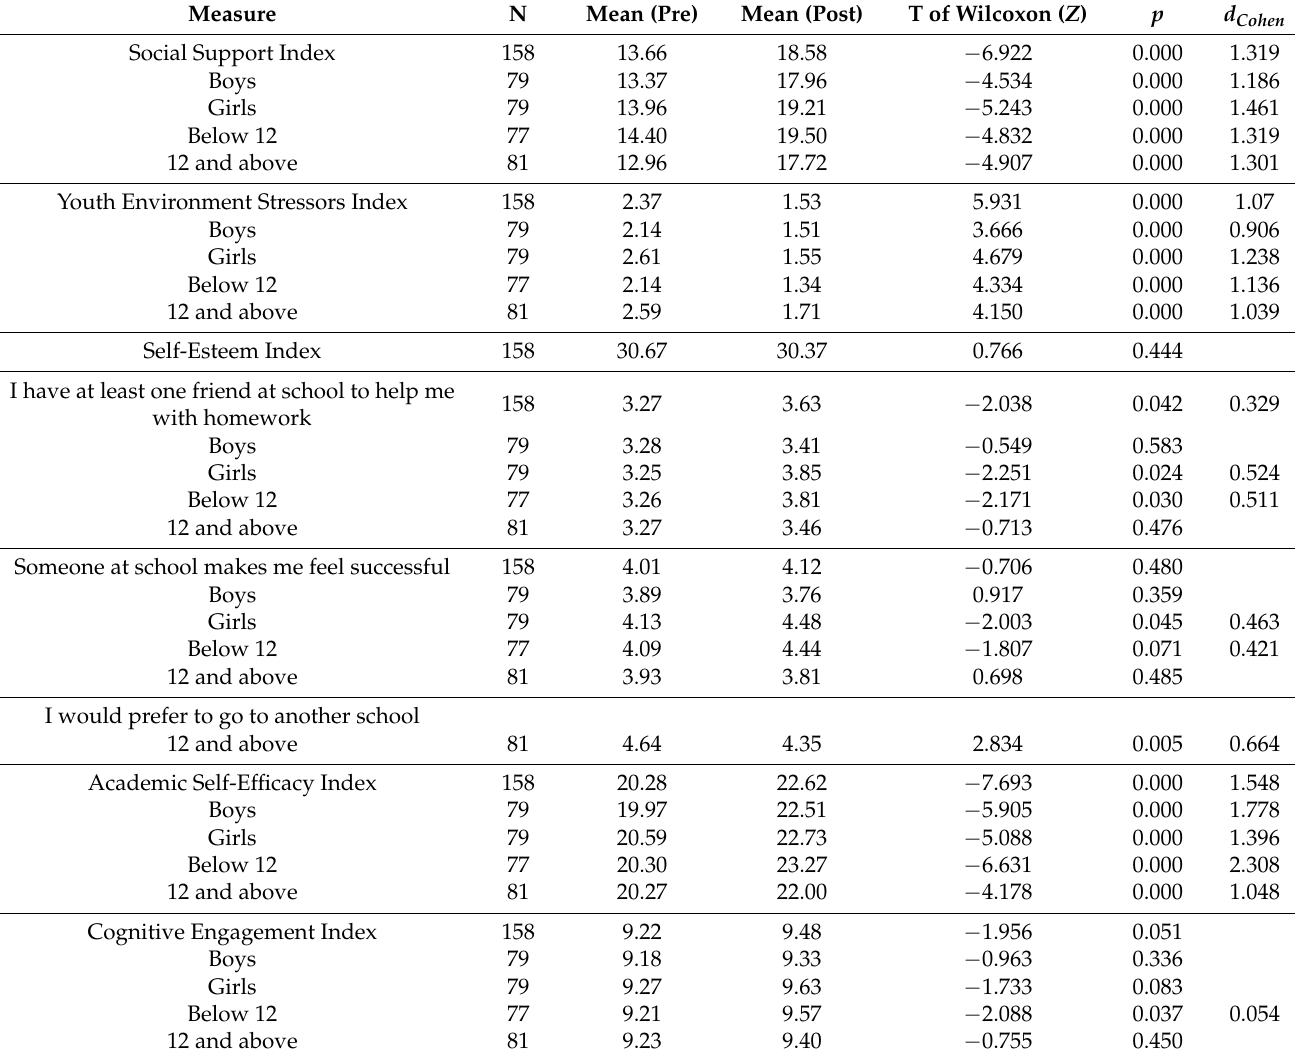
Table 2. Non-parametric tests for pre-post